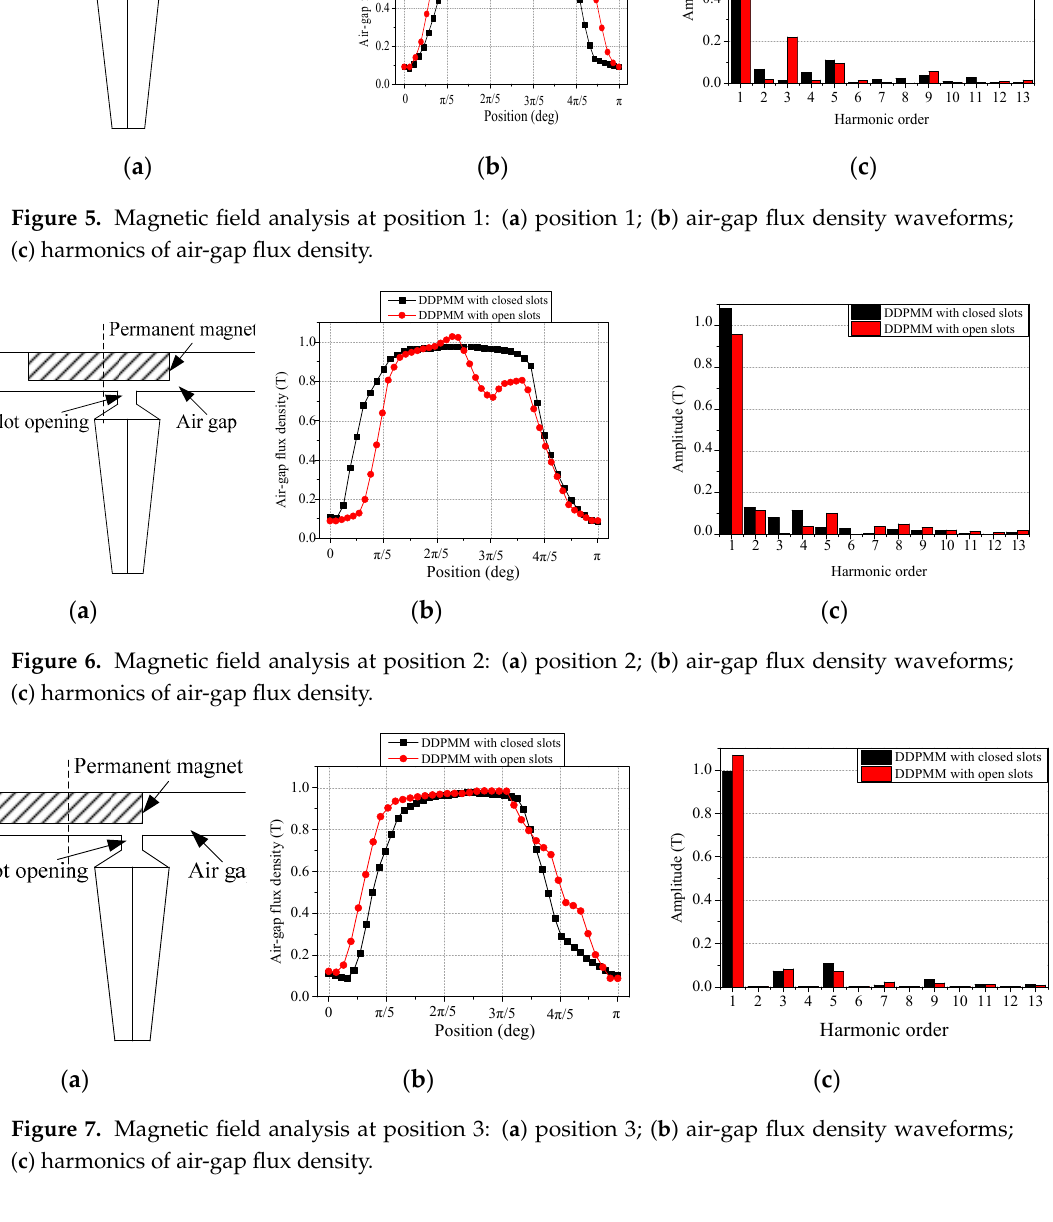
harmonics of air-gap flux density.